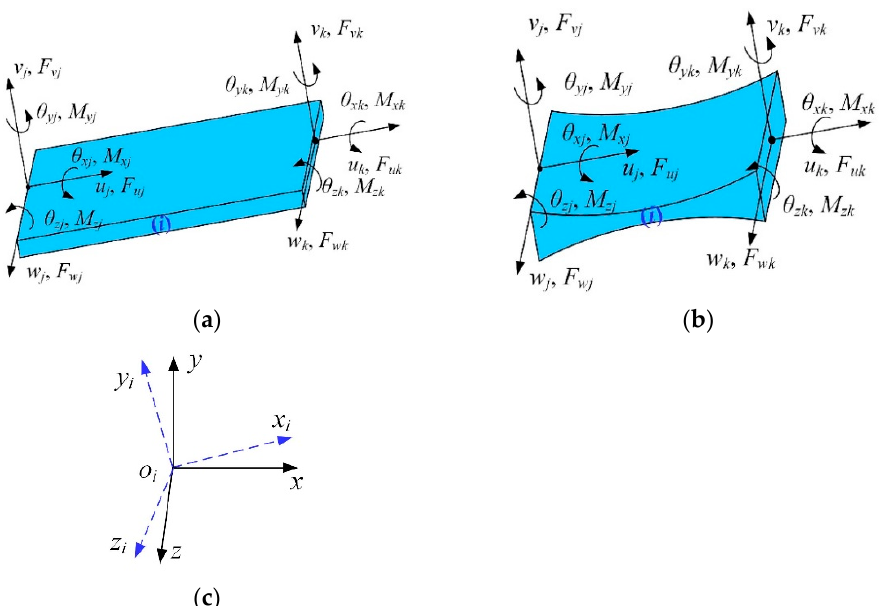
Figure 1. Nodal displacements and nodal forces of flexible elements: ( a ) the flexible beam with equal-section; ( b ) the flexible beam with variable-section; ( c ) the local and reference coordinate systems.